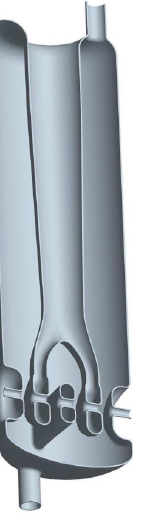
FIG. 10. (Color) ANSYS results of deformed geometries for case 1 (left) and case 2 (right). Only 1